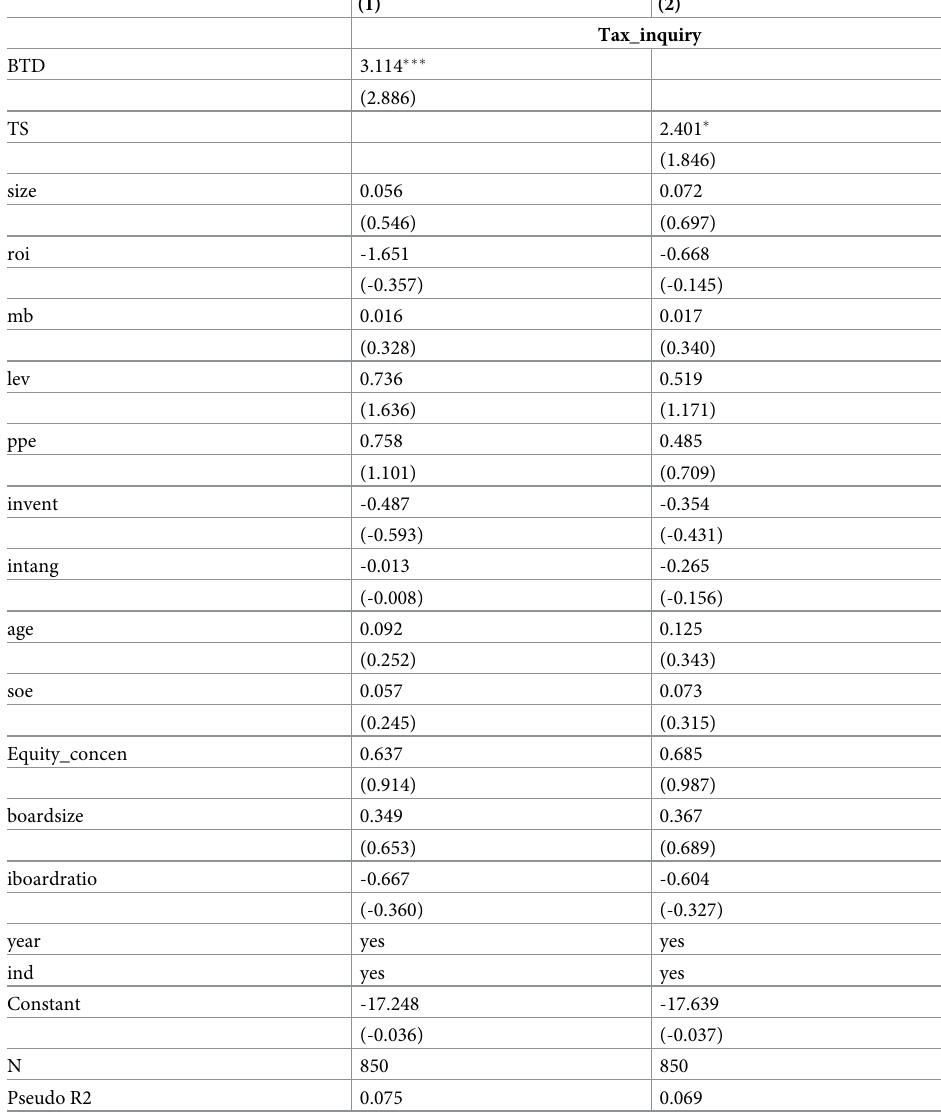
Table 4. Tax avoidance and likelihood of receiving tax-related comment